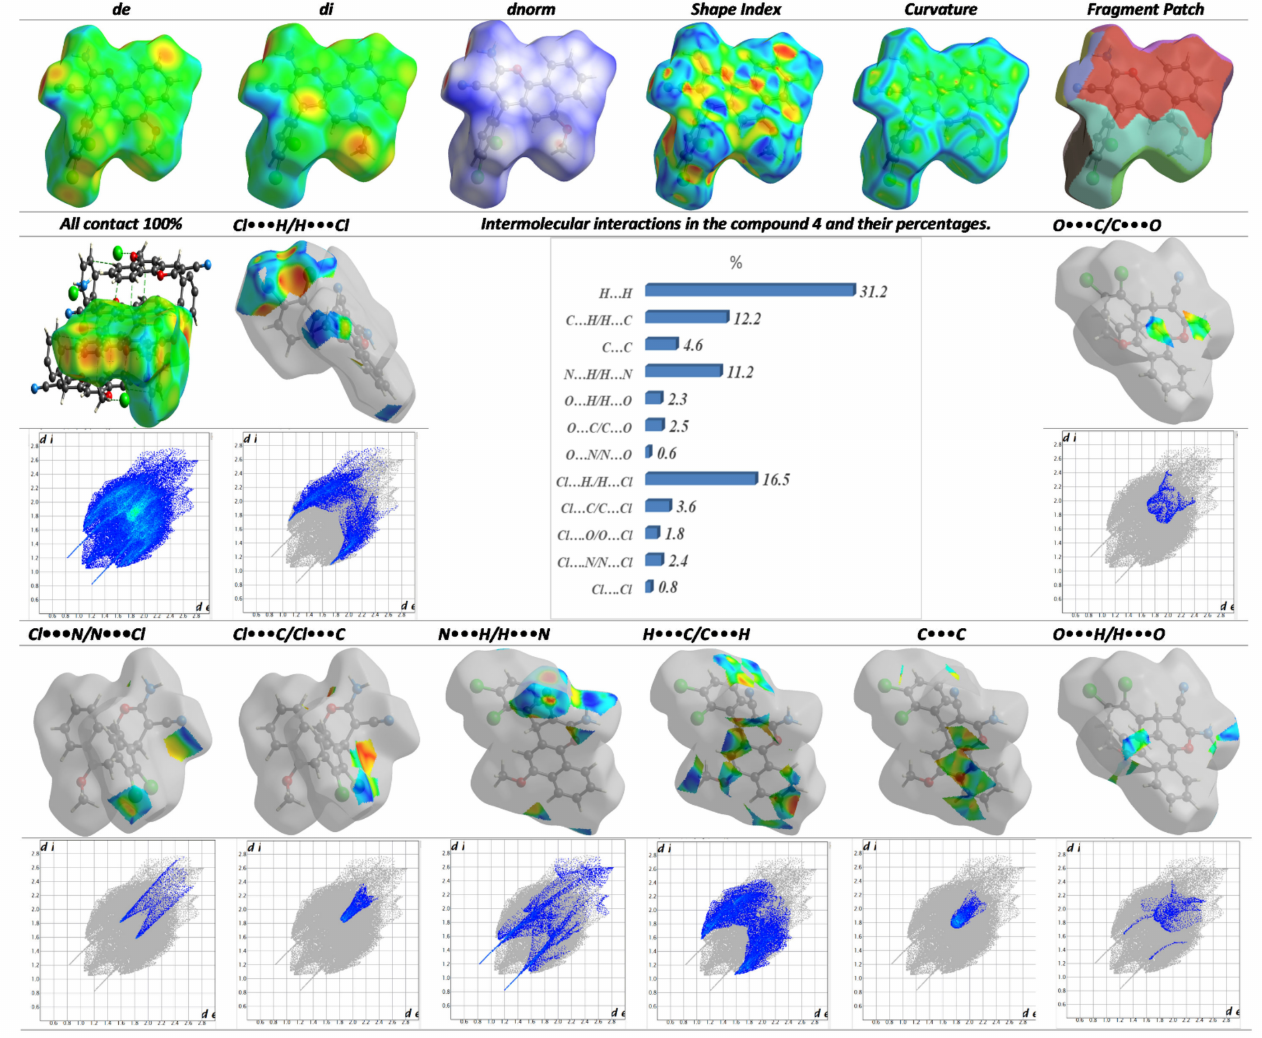
Figure 2. The HFM, represented in 2D interaction diagrams, and its contribution in compound 4 as represented in the d norm , d i , d e , shape index“si” , curvedness “crv”, and fragment batch “fb”